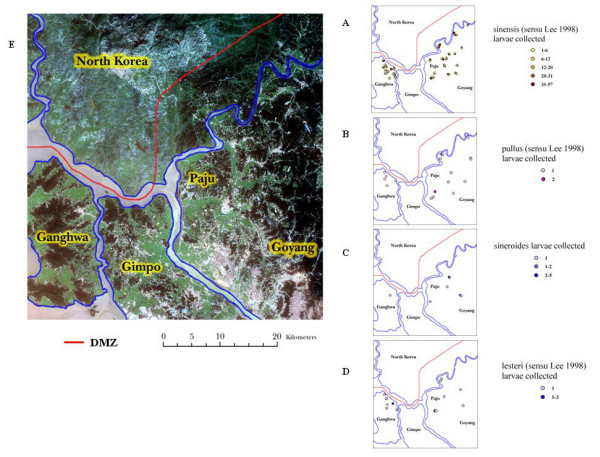
Thematic map showing numbers of anopheline larvae collected at various habitats; Shown are Anopheles sinensis in A, Anopheles pullus in B, Anopheles sineroides in C, and Anopheles lesteri in D, surveyed during August-September 2003, and LANDSAT 7 satellite data (dated 10 September 2002, spatial resolution 30 × 30 meters) displayed in true color (band combination 3, 2,1) in E.